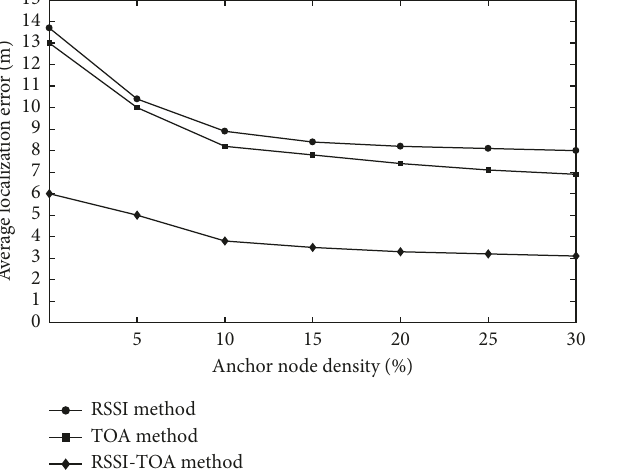
Figure 6: Relationship between localization error and anchor node density without mobile anchor node.